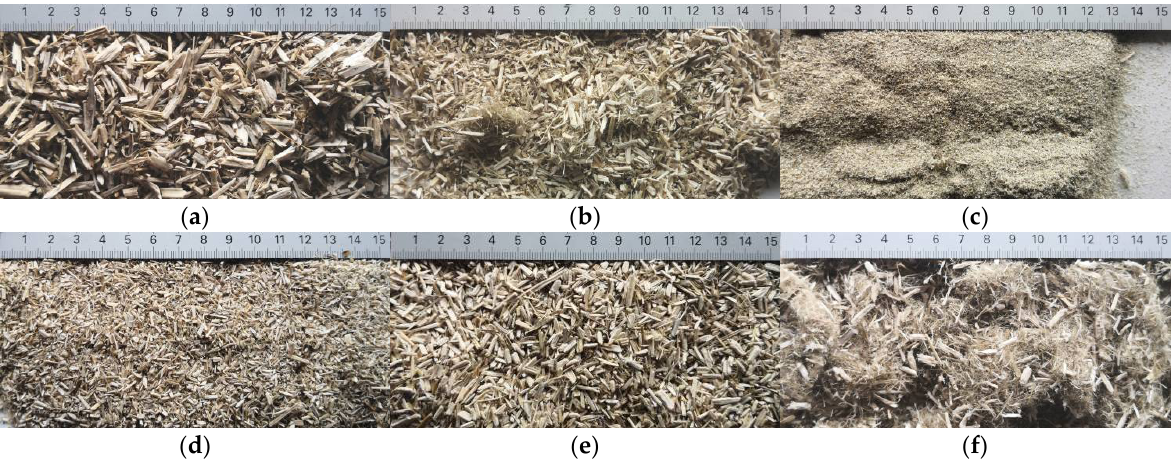
Figure 1. ( a ) HS before processing; ( b ) HS after milling; ( c ) HS particle size less than 0.5 mm; ( d ) HS-1 particle size range (0.5–2 mm); ( e ) HS-2 particle size range (2–5.6 mm); ( f ) MHF particle sizes over 5.6 mm.